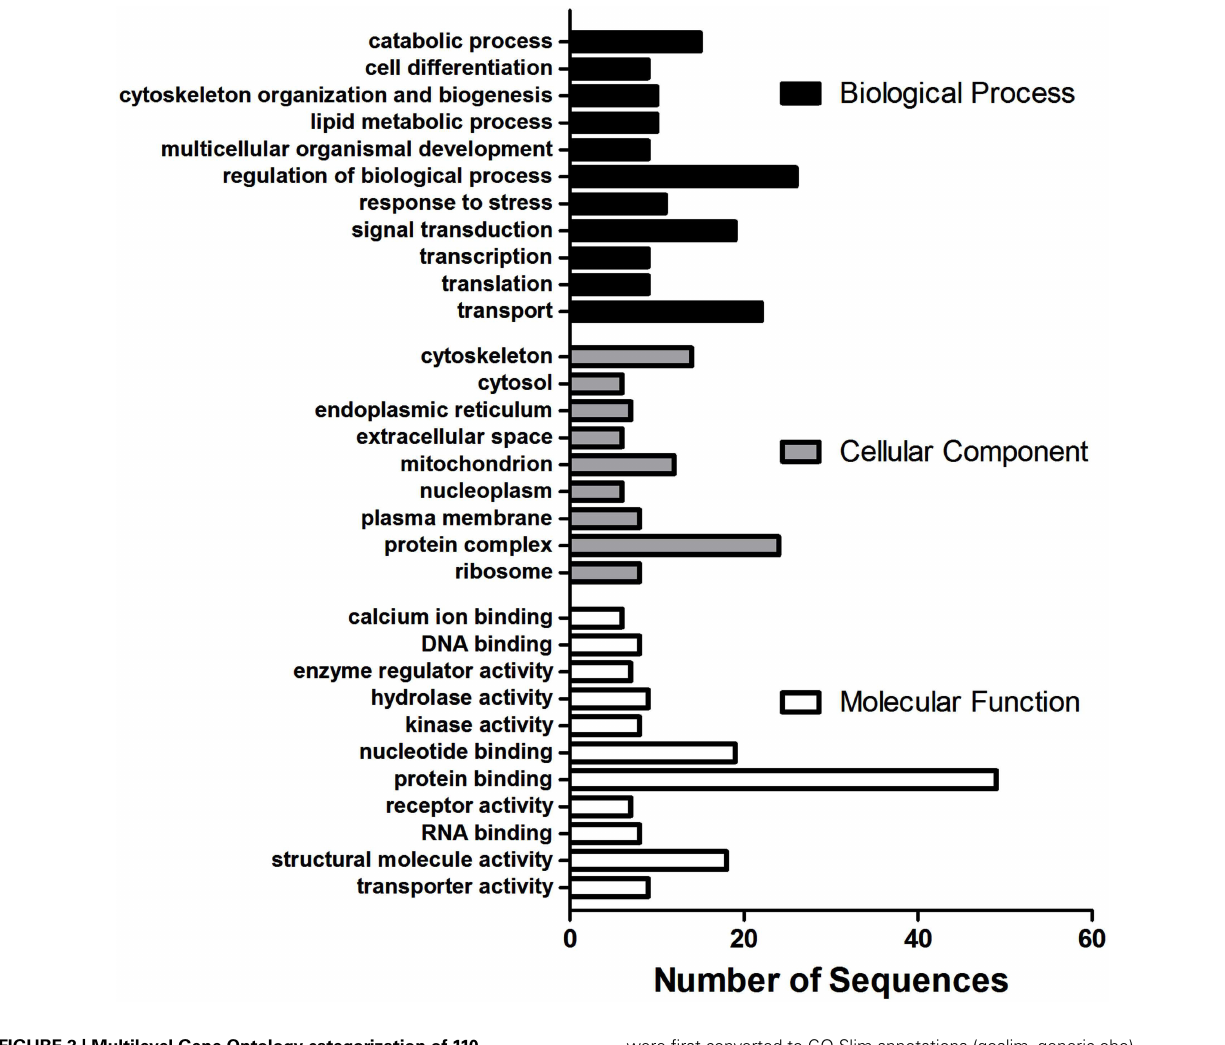
were first converted to GO-Slim annotations (goslim_generic.obo) and the multilevel chart was constructed using a sequence convergence cutoff of five (seven for Biological Process) to reduce the complexity of the